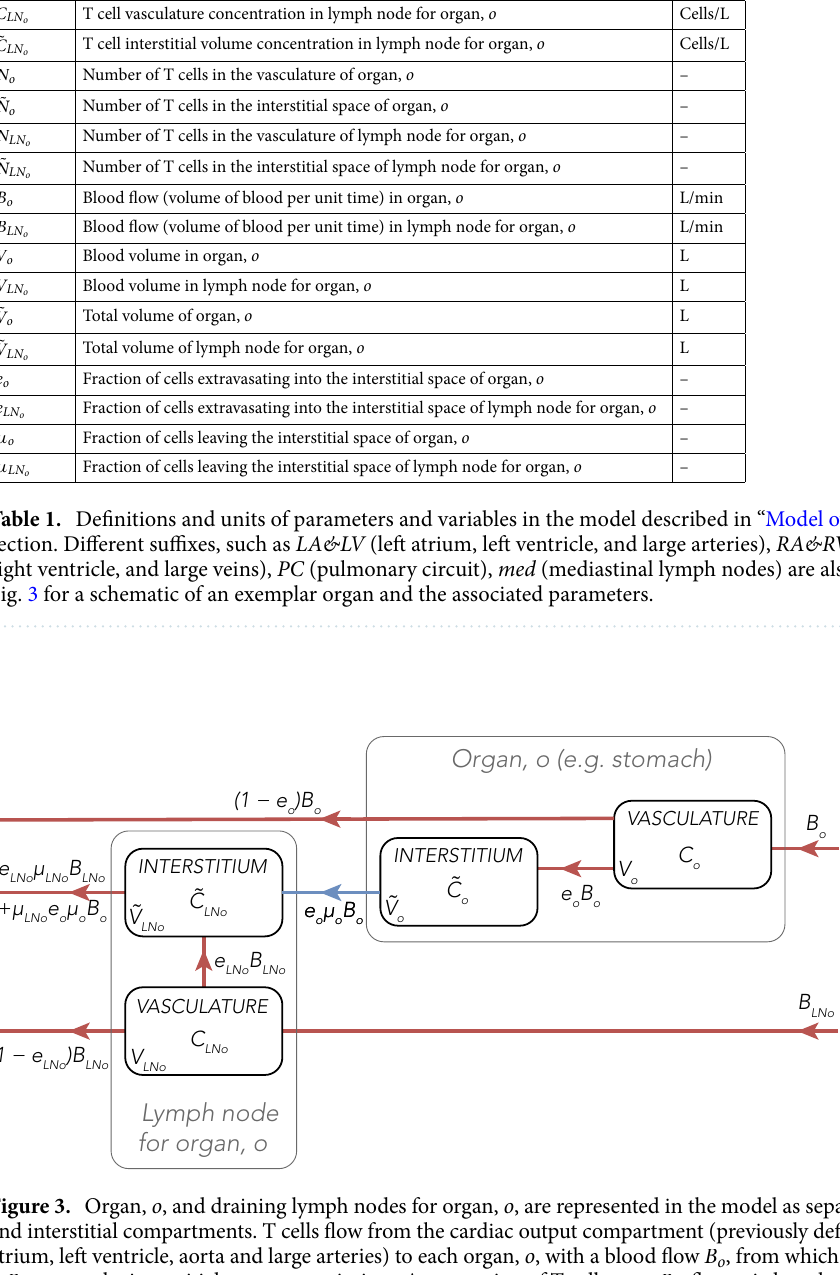
. From the lymph node o